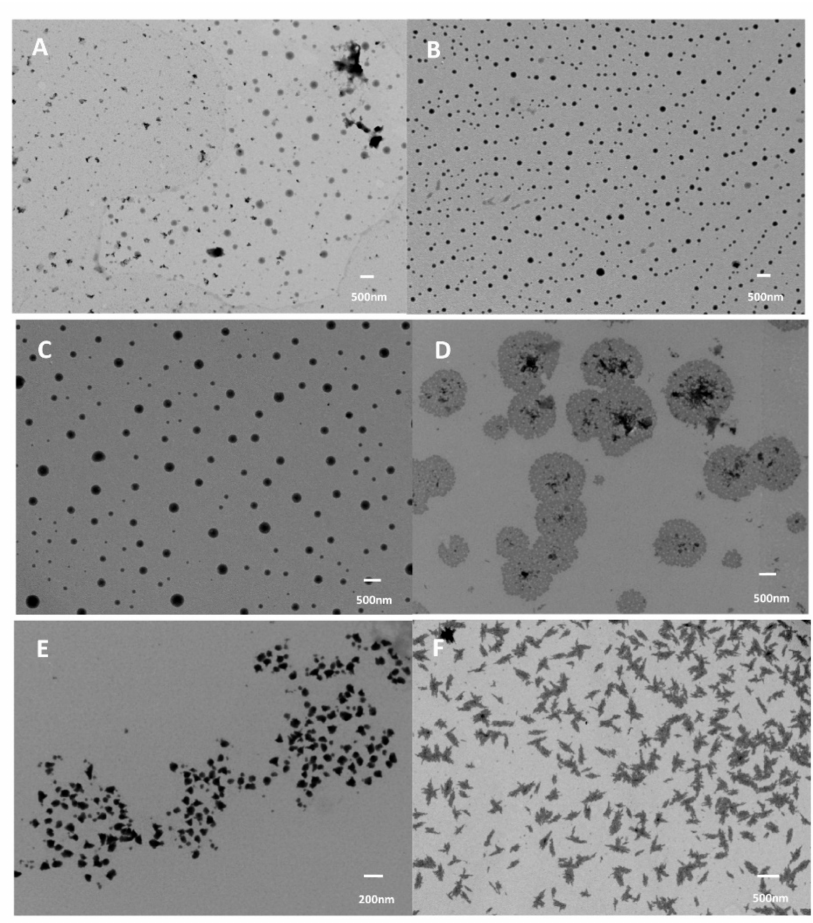
Figure 17. Differences in the morphology of wheat glutenin nanoparticles prepared at different oxidation times of 10 h ( A ), 20 h ( B ), 30 h ( C ), 40 h ( D ), 50 h ( E ), and 60 h ( F ). Reprinted with permission from ref. [99]. Copyright 2019